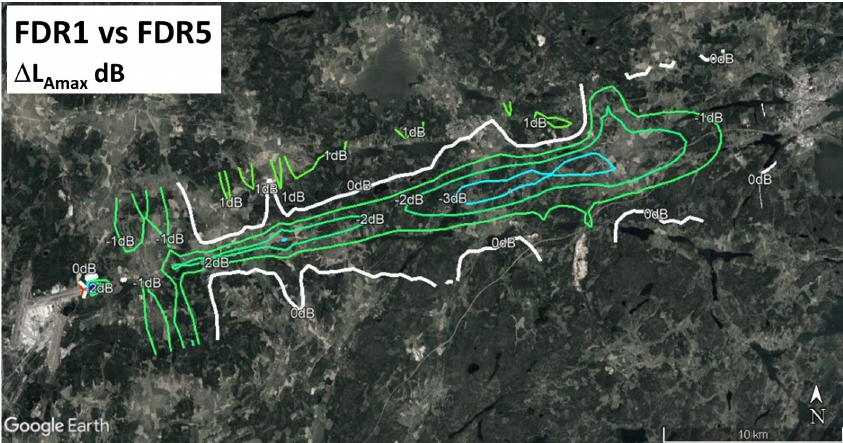
Figure 15. Noise prediction difference of FDR1 with respect to FDR5 using SAFT ECAC Doc 29 implementation.